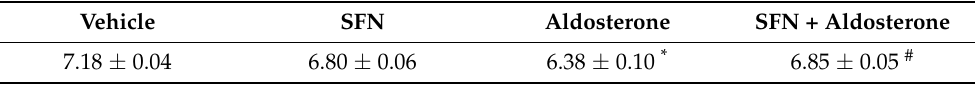
Figure 2. Pharmacological activation of Nrf2 attenuates aldosterone-induced impairment in redox state. Concentration-effect curves ( A ) and maximum response ( B ) to acetylcholine in the thoracic aortas of C57BL/6J mice. Superoxide anion ( C ) and hydrogen peroxide ( D ) generation. Experiments were performed in the presence of Aldo (100 nM for 30 min) or SFN (1 µ M for 3 h). Data represent the mean ± SEM. One-way ANOVA: * p < 0.05 vs. basal; # p < 0.05 vs. Aldo; n = 5–9 for each experimental group. Table 2. pEC50 values for ACh-induced relaxation in the thoracic aortas of C57BL/6J treated with aldosterone in the presence of vehicle or